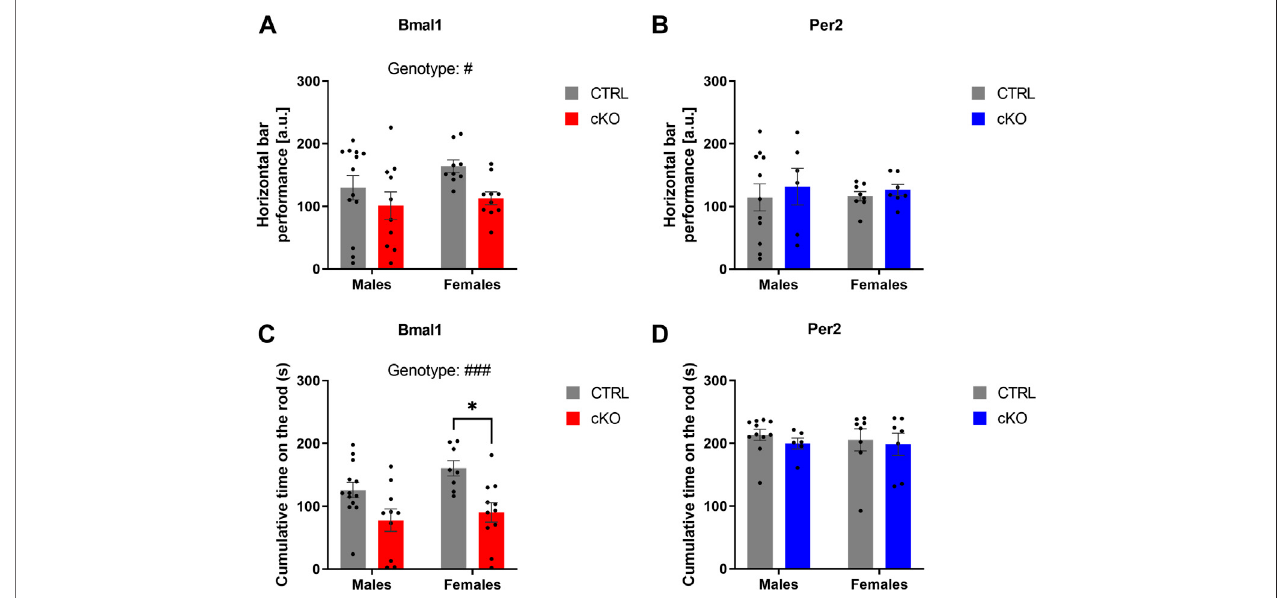
FIGURE 3 | Motor functions in mice with a conditional Bmal1 or Per2 knockout and controls. Mice with a striatal-speci fi c Bmal1 knockout (n = 9 – 13 per genotype andsex)performedworseinthehorizontalbartestcomparedtocontrols (A) ,whereasnodifferenceswerefoundinmicewithaknockoutof Per2 (n=6 – 11pergenotype and sex) (B) from striatal MSNs. Likewise, Bmal1 knockout mice (n = 8 – 13 per genotype and sex) (C) had de fi cits in motor coordination assessed in the rotarod in contrast to mice with a conditional ablation of Per2 (n = 6 – 11 per genotype and sex) (D) from striatal MSNs. Results are depicted as mean ± standard error of